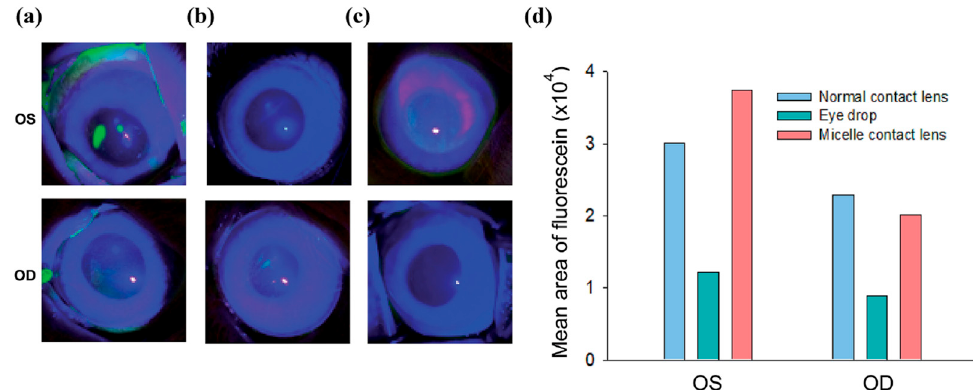
Figure 6. Corneal inflammation inspection by corneal fluorescein staining followed by ( a ) normal contact lens wear in OD, ( b ) CsA eye drop administration, and ( c ) CsA/C-HA micelle contact lens wear in OD. ( d ) The ROI (region of interest—ROI) values for fluorescein staining (oculus dexter—OD, oculus sinister—OS). In case of micelle CL, the OS did not contain any CsA, so the fluorescein staining showed increased intensity than the OD. Oculus dexter is abbreviated as OD, meaning right eye, and oculus sinister is abbreviated as OS, meaning left eye. Reprinted with permission from reference [103]. Copyright the Royal Society of Chemistry.